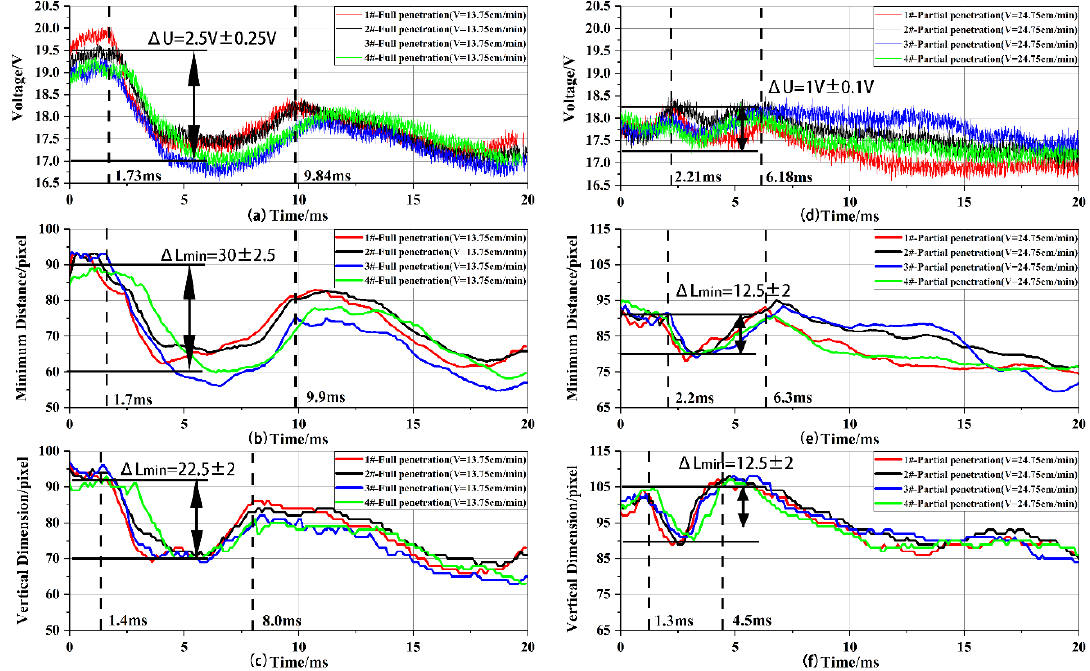
Figure 14. the synchronous curves of the voltage signal, the minimum distance (L min ) and the vertical dimension (LV). Full penetration (V = 13.75 cm/min): ( a – c ). Partial penetration (V = 24.75 cm/min): ( d – dimension (LV). Full penetration (V = 13.75 cm / min): ( a – c ). Partial penetration (V = 24.75 cm / min): ( d – f f ).